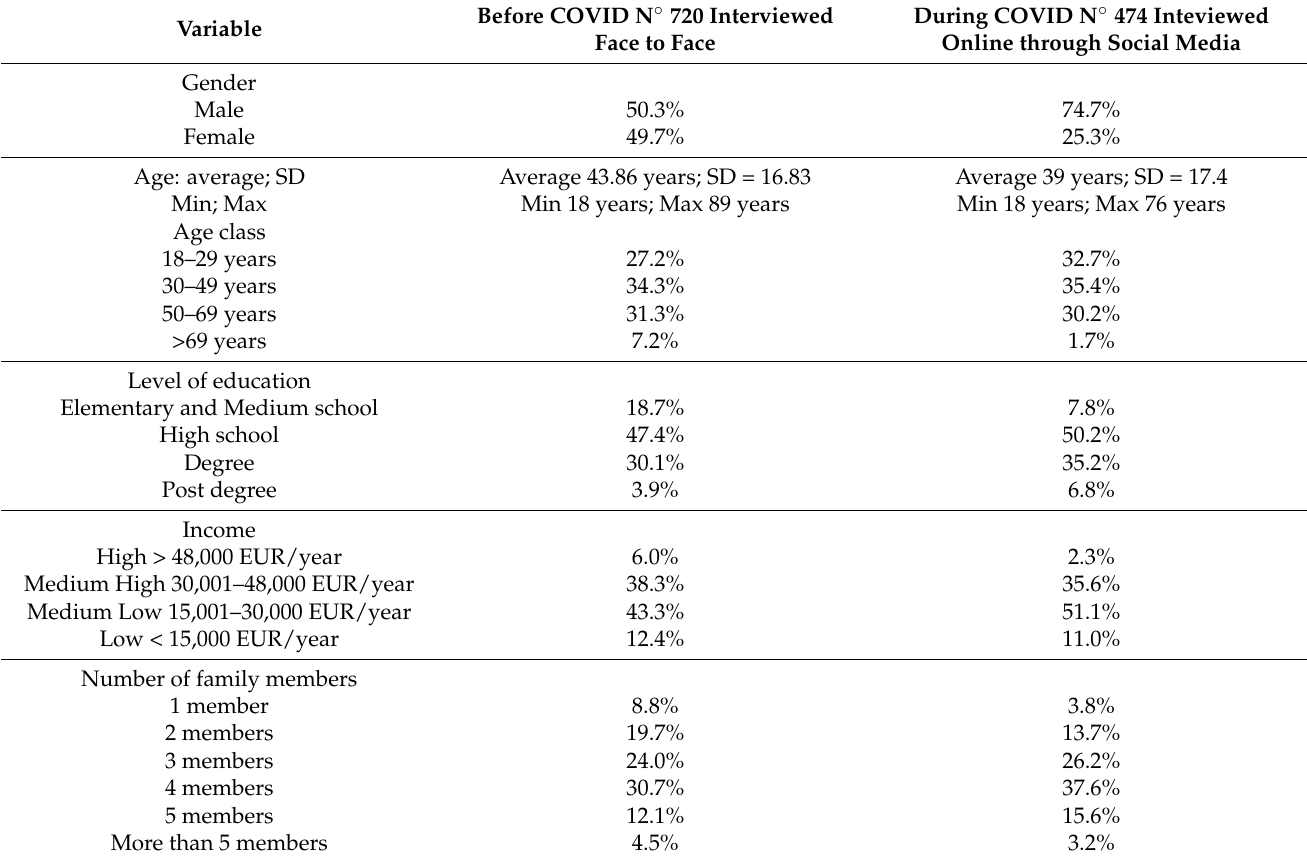
Table 2. Descriptive characteristics of the sample of consumers